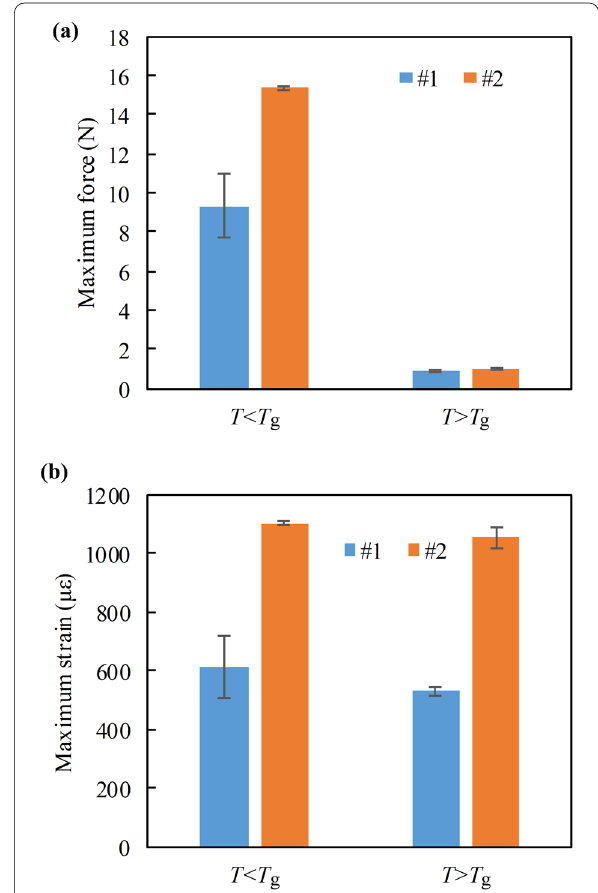
Fig. 10 Maximum force ( a ) and strain ( b ) for different